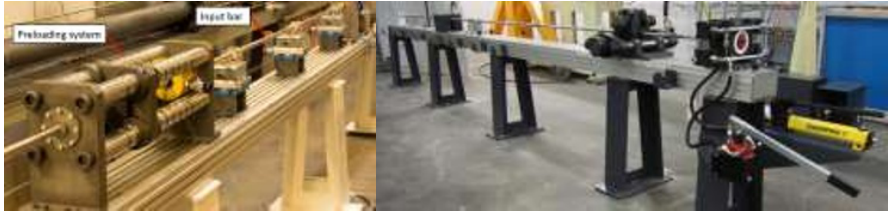
Fig. 4. Split Hopkinson Tensile (left) and Torsional (right) Bars